Question: What style of plot is this figure drawn as?
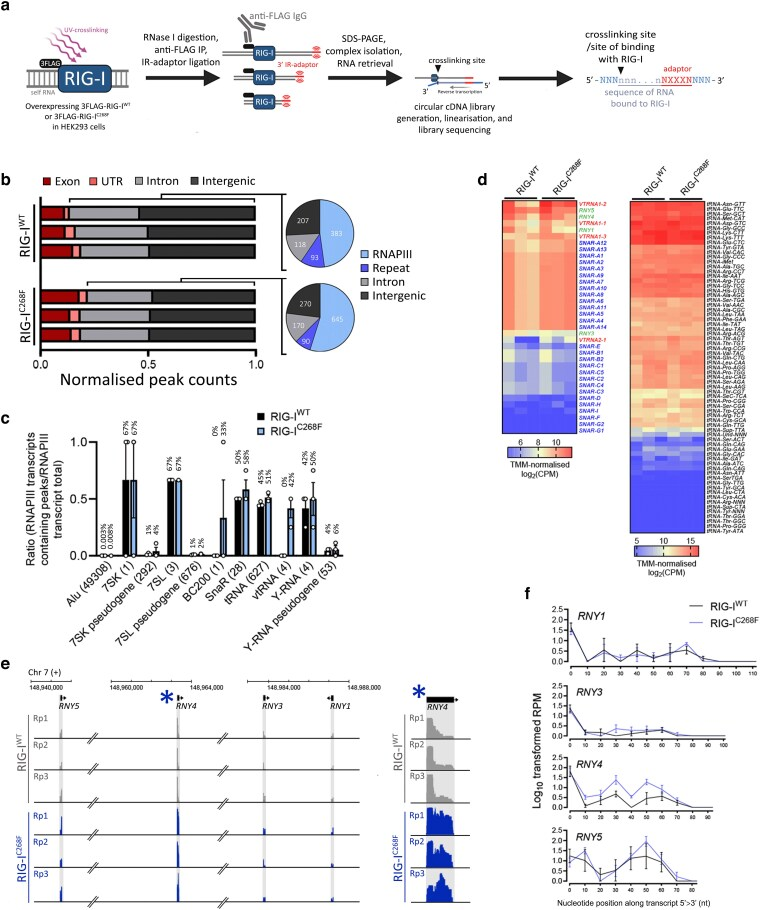
Answer: heatmap